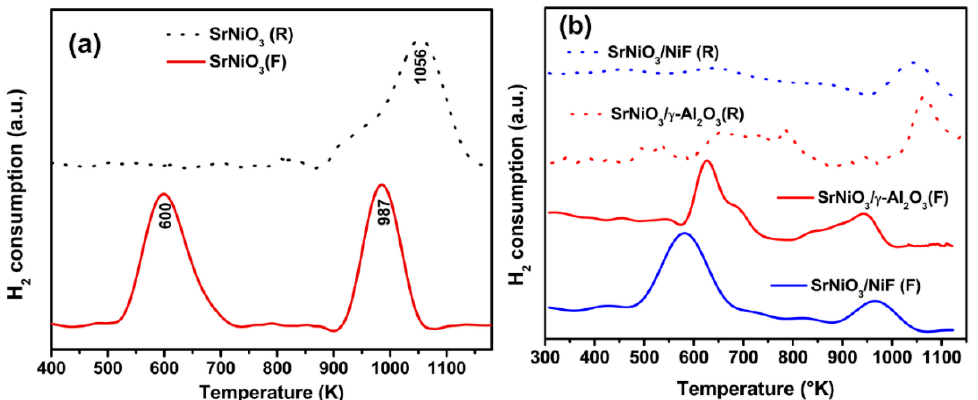
Figure 4. H 2 -TPR of ( a ) unreduced (F) and reduced (R) SrNiO 3 perovskite unsupported catalysts and ( b ) SrNiO 3 (F and R) supported with γ- Al 2 O 3 , and nickel foam catalysts.